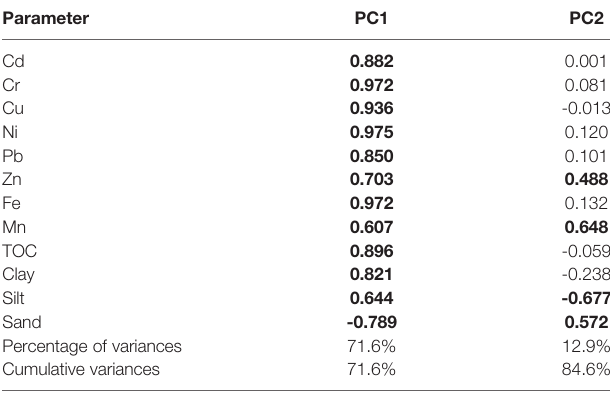
TABLE 5 | Loadings of experimental variables on signi fi cant principal components for the data from Zhanjiang bay. Parameter PC1 PC2